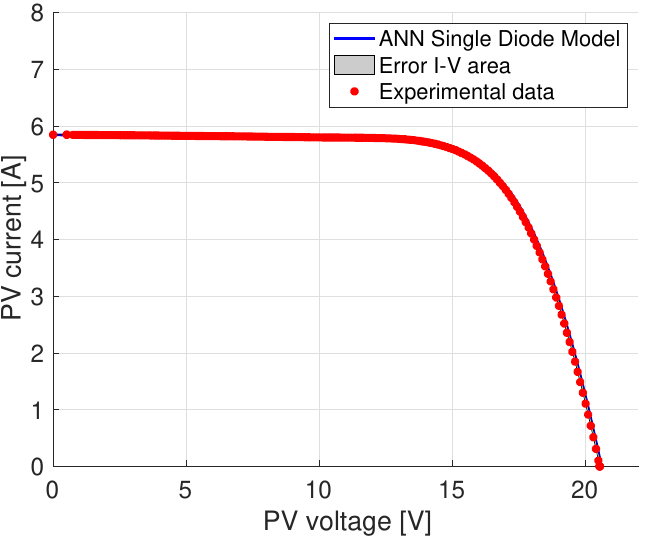
Figure 12. Comparison of experimental data and reconstructed single-diode I - V curve with estimated ANN parameters in healthy condition. In this case, the error area is